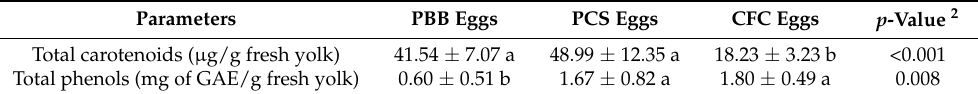
Table 4. Antioxidant profile of the egg yolks 1